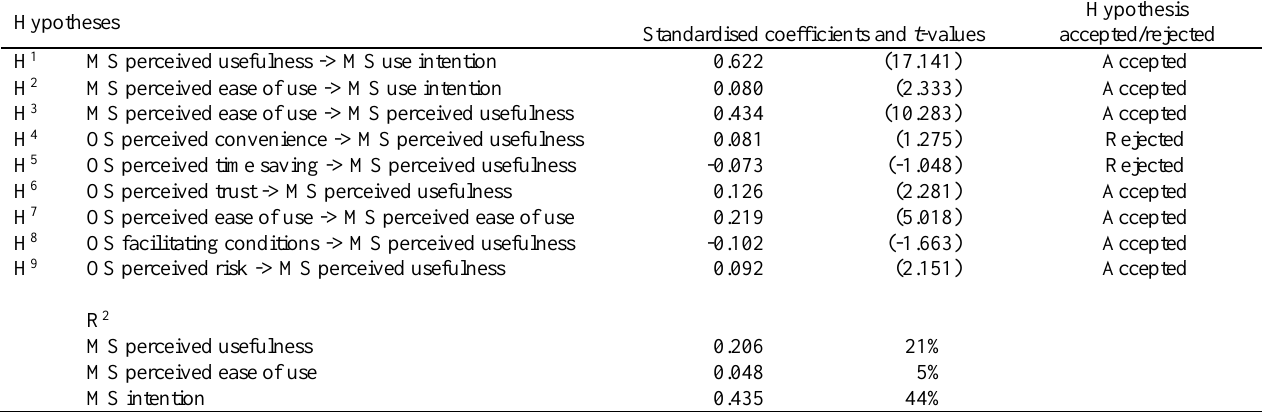
Figure 2: Results of the structural model assessment Table 4: Summary of the